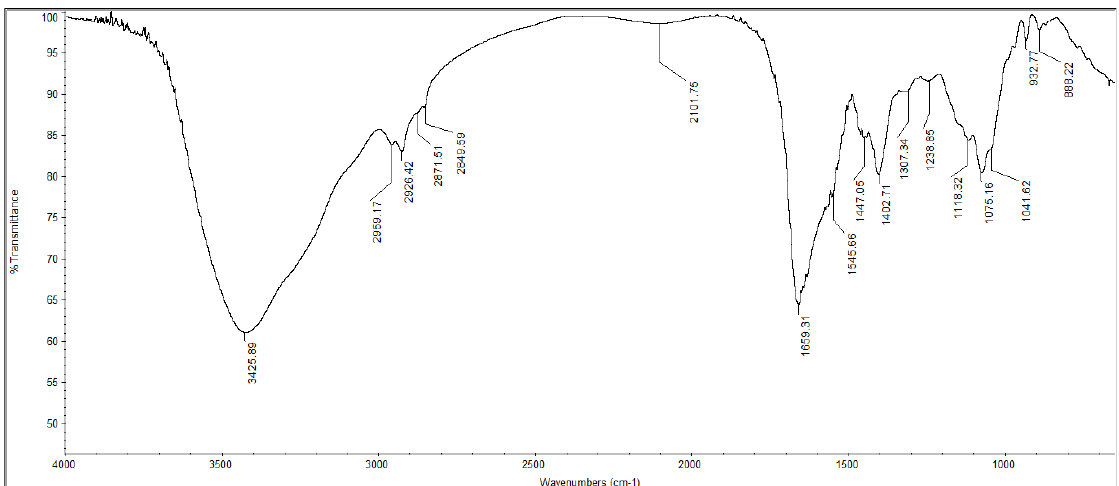
Figure 6. FT − IR spectroscopy spectrum of hyaluronidase enzyme. FTIR Band assignments of hyaluronidase in the region of 4000–500 cm − 1 . FTIR compared with Raman Spectroscopy for CASMTK1 in a range of 50 0–3000 cm −1